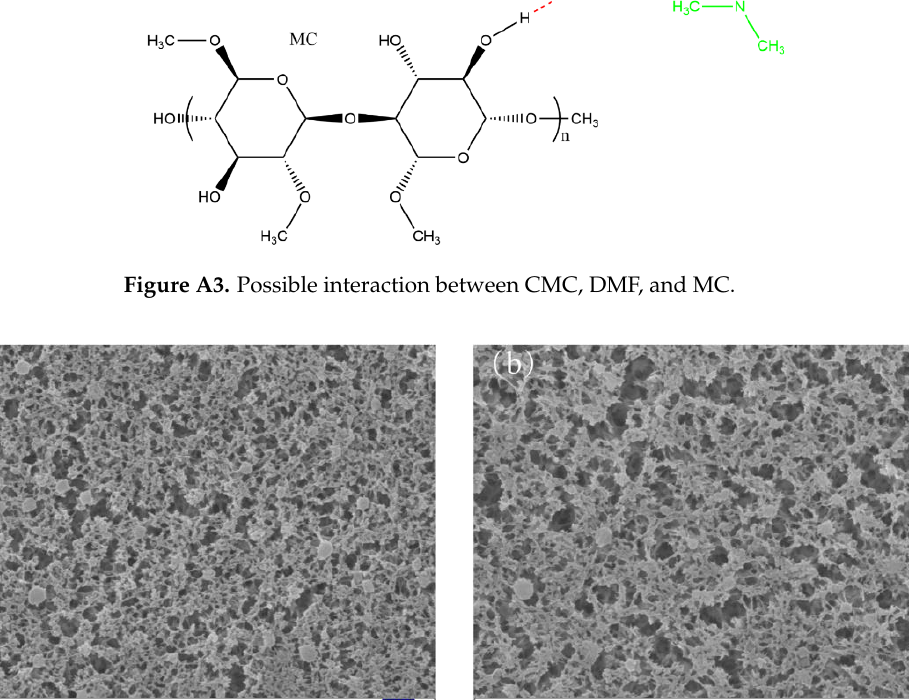
Figure A4. SEM micrograph of the bottom surface of CPMs: ( a ) CPM-0; ( b ) CPM-5. There was no significant difference in the microstructure of the bottom surface of the CPM with different MC contents, as shown in Figure A4a (CPM-0) and A4b (CPM-5).